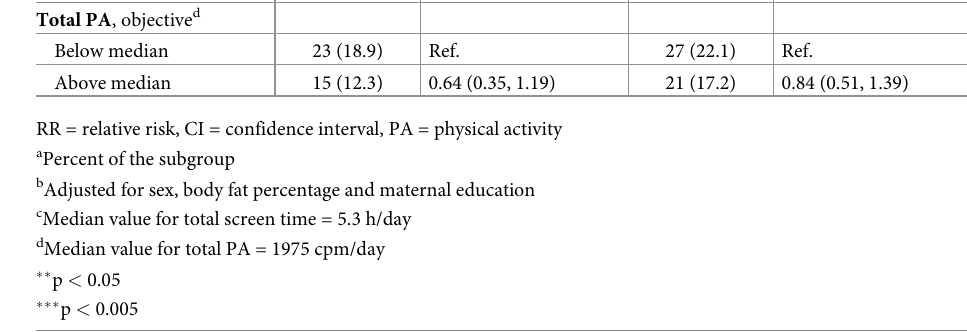
Dividing the participants into four subgroups based on both self-reported screen time and vigorous physical activity (Table 4) revealed that those reporting both less screen time and more frequent vigorous physical activity had a significantly lower risk of reporting symptoms of depression (RR = 0.06, 95% CI = 0.01–0.41), anxiety (RR = 0.16, 95% CI = 0.06–0.45), low self-esteem (RR = 0.16, 95% CI = 0.05–0.48) and life dissatisfaction (RR = 0.30, 95% CI = 0.15– 0.61) compared with those reporting both greater screen time and less frequent vigorous phys- ical activity, after adjusting for sex, maternal education and percentage body fat. A significantly lower risk of reporting life dissatisfaction was also found for those reporting having both less